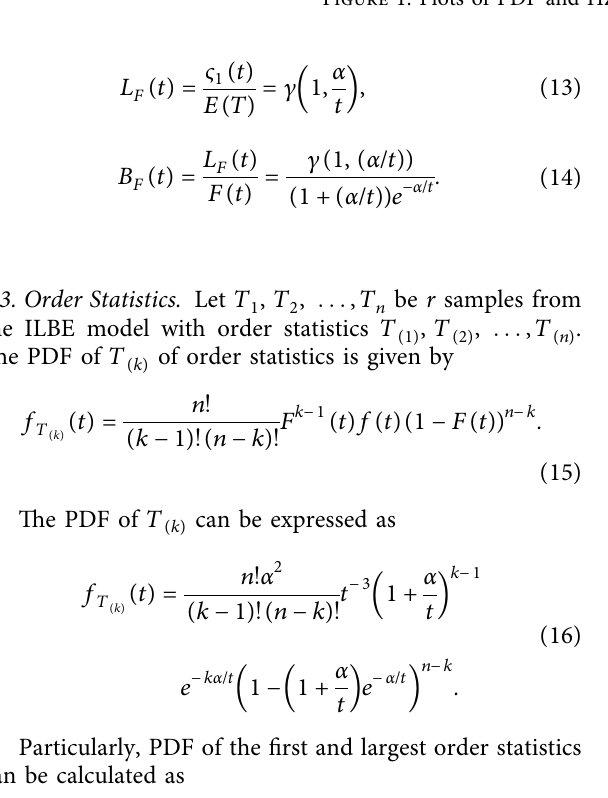
Figure 1: Plots of PDF and HZRF for the ILBE